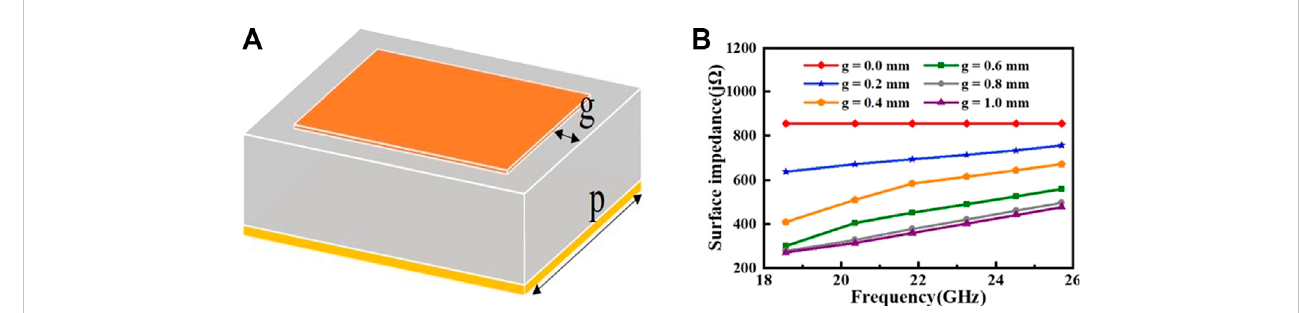
FIGURE 1 (A) Geometrical structure. (B) Surface impedance versus frequency for different gap g .